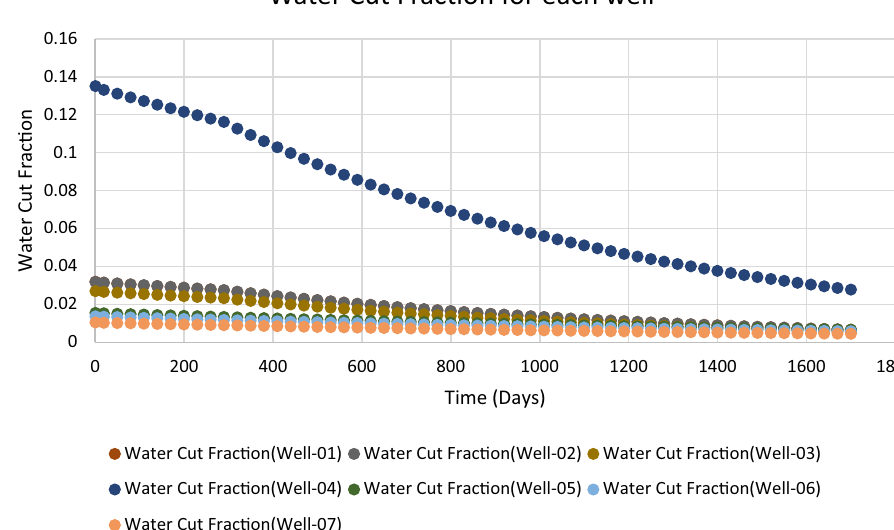
Fig. 8 Water cut percentage for each well